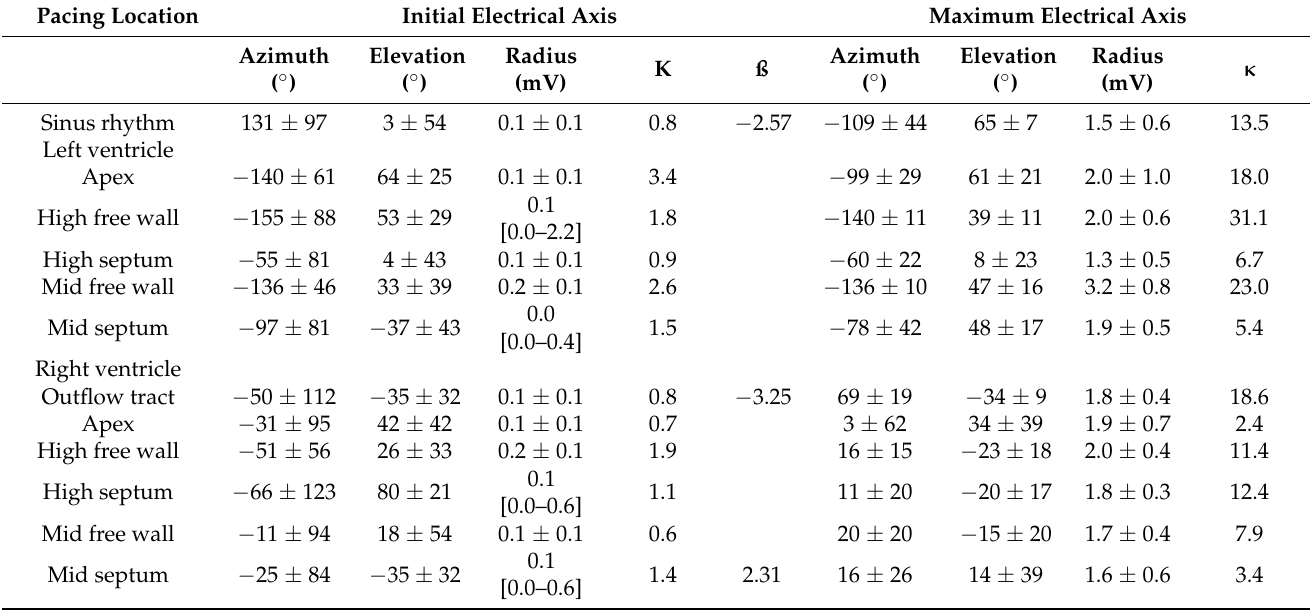
Table 1. Descriptive statistics of the electrical axes’ distribution for sinus rhythm as well as the different induced ventricular premature depolarizations. The initial electrical axis was measured as the local maximum radius during the first 40 ms of the QRS complex. If no local maximum could be found, the initial electrical axis was defined as the maximum during the first 40 ms of the QRS complex. The maximum electrical axis was measured as the maximum radius over the entire QRS complex. The higher the value of concentration parameter κ , the more concentrated the axis direction. In cases where the electrical axes followed a Kent instead of a von Mises–Fisher distribution, the ovalness parameter ß was given. A higher absolute value of ß indicates a more elliptical (flatter) distribution. Normally distributed values are described as mean ± standard deviation while non- normal distributed values are described as median (range).